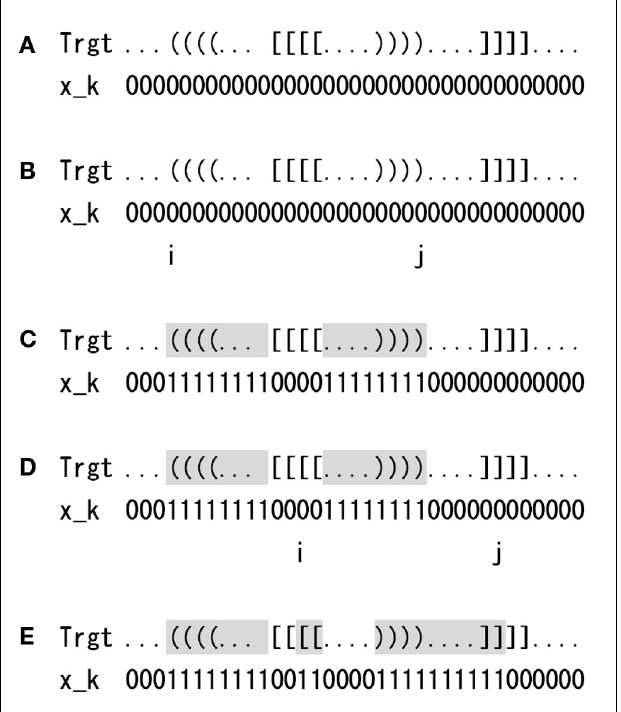
FIGURE 1 |An example of structural n -point crossover operator for pseudoknotted target structure. Trgt and x_k indicate a target structure and a crossover position indicator, x k , respectively. (A) An initial state. All x k s are set to zero. (B) Position i is randomly selected. Position j is the position complementary to the position i . (C) The values of x k s between i and j are changed to 1.The values in the pseudoknotted region are not changed.The positions whose x k = 1 are shaded.We can use the x k s obtained after this step as a crossover position indicator for a 4-point crossover. (D) In addition, we can randomly select one more position i to increase the crossover points. (E) In this example, as a result, we can obtain a crossover position indicator for a 6-point crossover, which is composed of 7 subsequence